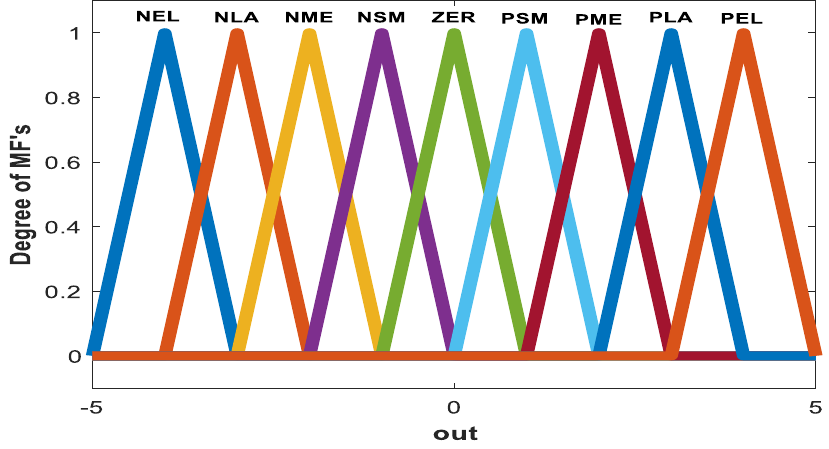
Figure 9. Output variable MFs.